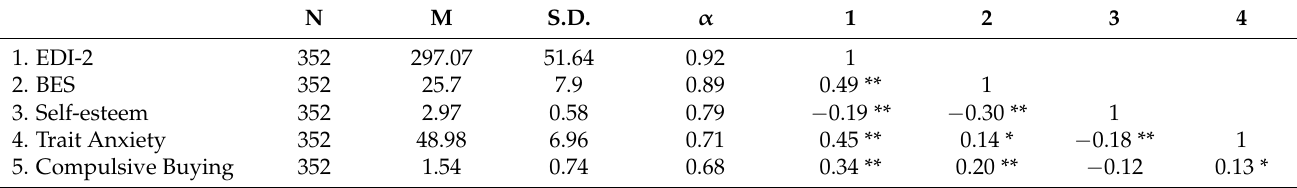
Table 1. Means, deviations and correlation values among variables.